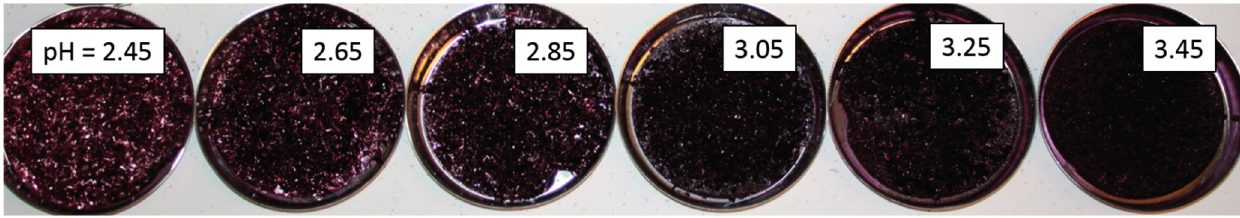
Figure 3. KHT precipitates from Concord juices as a function of